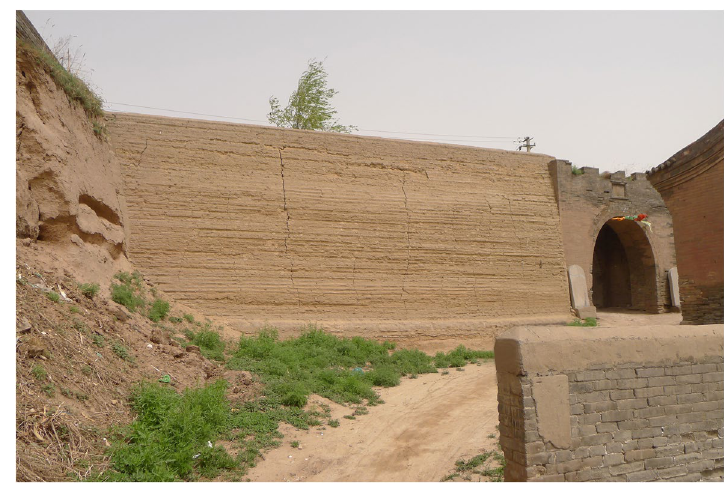
Fig. 23 The effect of the wall after restoration (Source: the author)